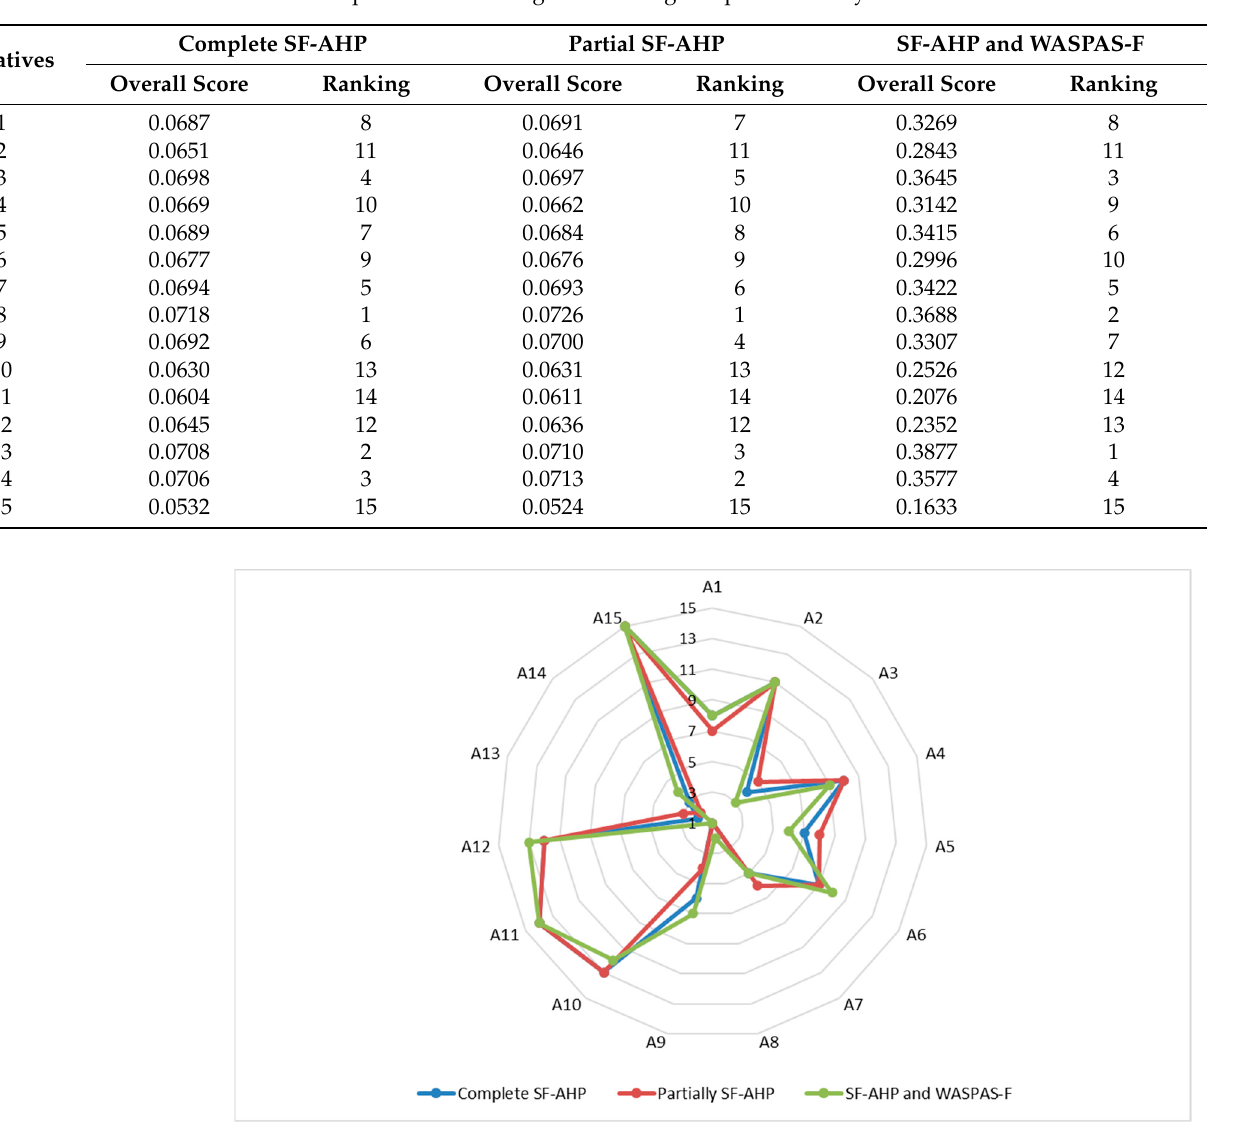
Table 10. Comparisons of ranking results using comparative analysis.